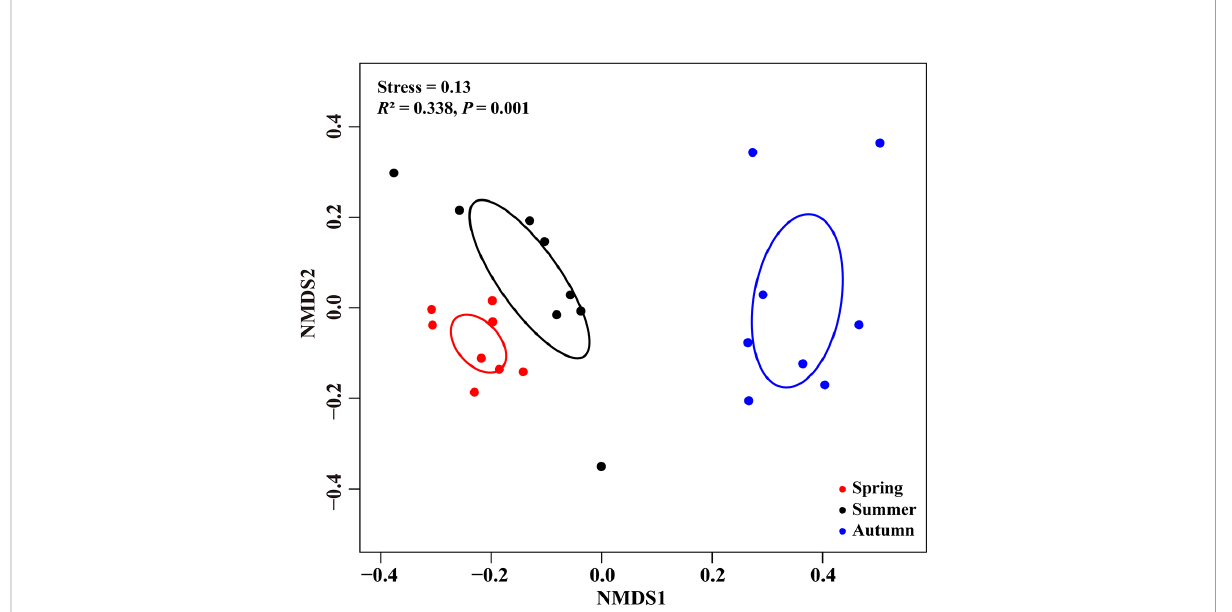
FIGURE 4 Nonmetric multidimensional scaling (NMDS) ordination of fungal community composition based on Bray-Curtis distance among seasons. Ellipses delimit 95% con fi dence intervals around centroids for each